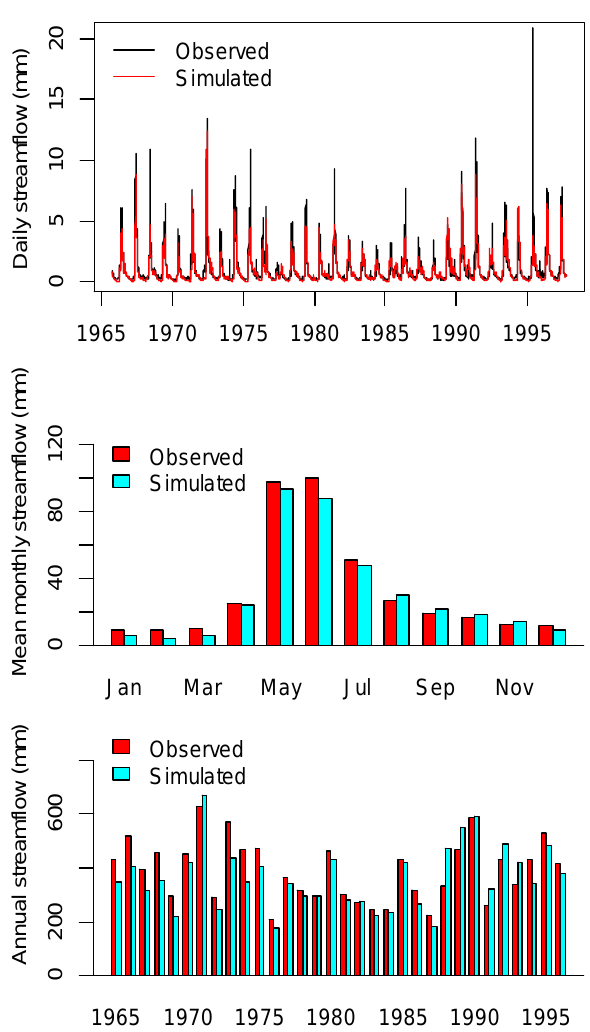
Fig. 4. Observed and HBV-EC-simulated daily, monthly and annual streamflows during the calibration period from 1965 to 1997. HBV- EC is driven by the daily climates observed at Coleman station.